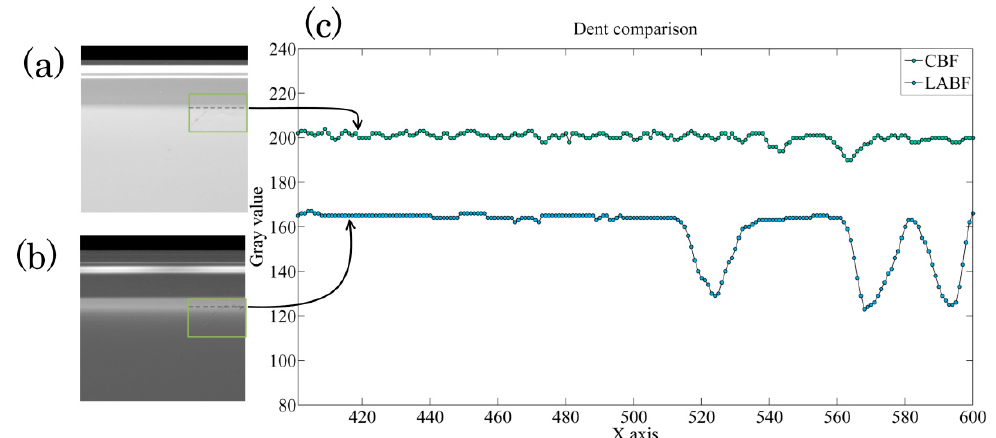
Figure 3. Grayscale distribution of the dent defect: ( a ) Typical image of a dent defect in the CBF system; ( b ) Typical image of a dent defect in the LABF system; ( c ) Grayscale distributions of a dent defect in the CBF system and LABF system.